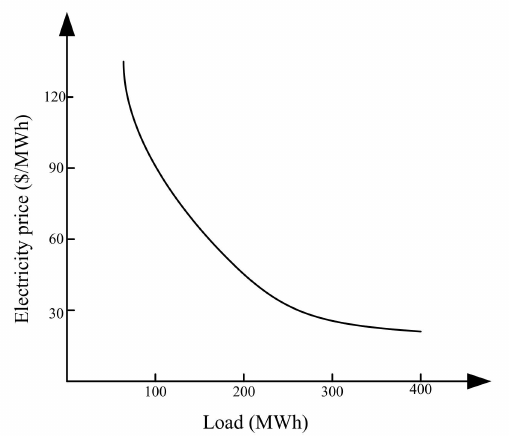
Figure 1. Electricity price against load